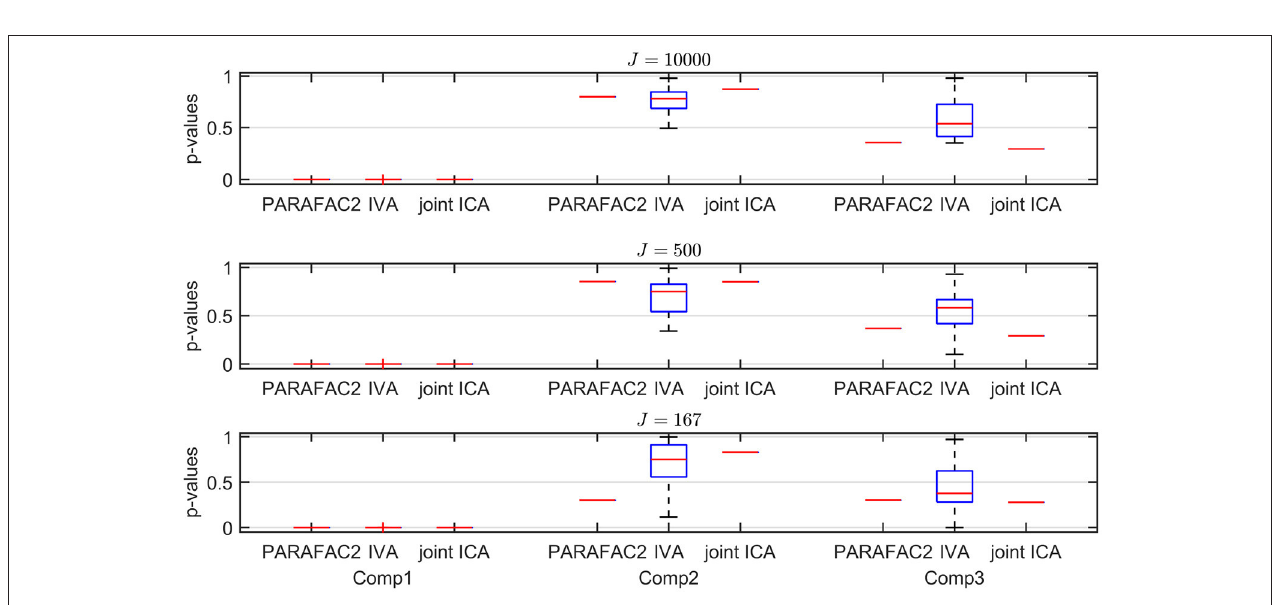
FIGURE 5 | Case 1a ( K = 20). p -values obtained using the two-sample t -test on the subject-mode patterns ( A or A k ) using different methods as the number of voxels (i.e., J ) changes, where the number of time slices (i.e., K ) is set to 20. Based on the true subject-mode patterns, true p -values are 0, 0.88, and 0.35 for component 1, 2, and 3, respectively. For large sample size, i.e., J = 10,000, all methods can identify that the first component is the statistically significant one in terms of group difference. As J decreases, in addition to the first component, IVA returns small p -values for other components in some windows corresponding to false-positive cases while PARAFAC2 and joint ICA work well regardless of the sample